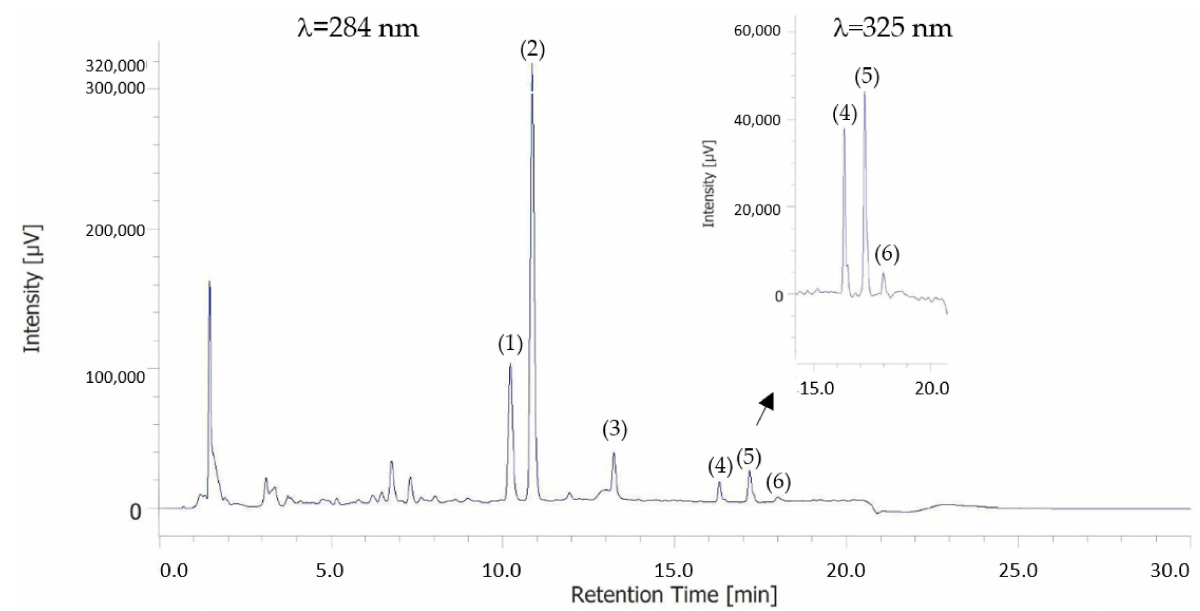
Figure 1. Example of chromatogram showing the flavonoid profile of the sample at 284 and 325 nm. (1) Naritutin. (2) Hesperidin. (3) Didymin. (4) Sinensetin. (5) Nobiletin. (6)